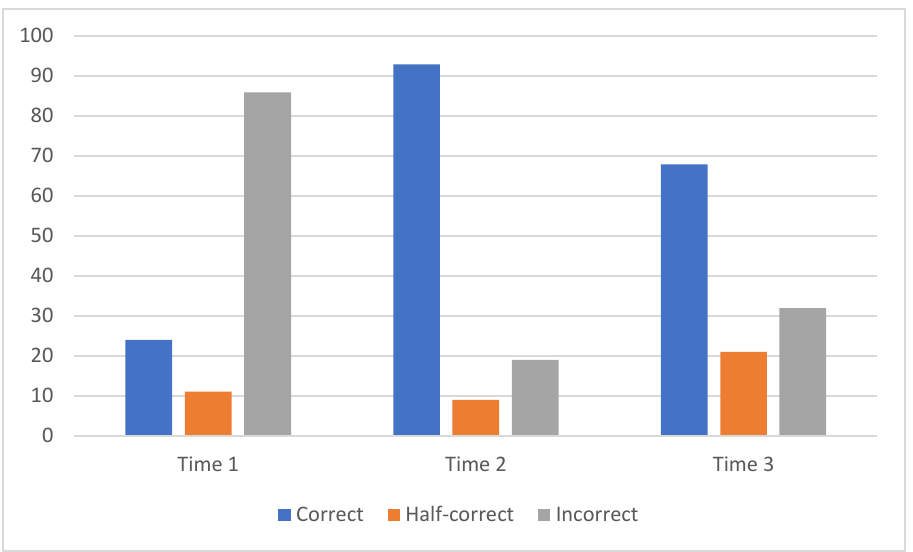
Figure 1. Accuracy of definitions of an asylum seeker at Times 1, 2, and 3